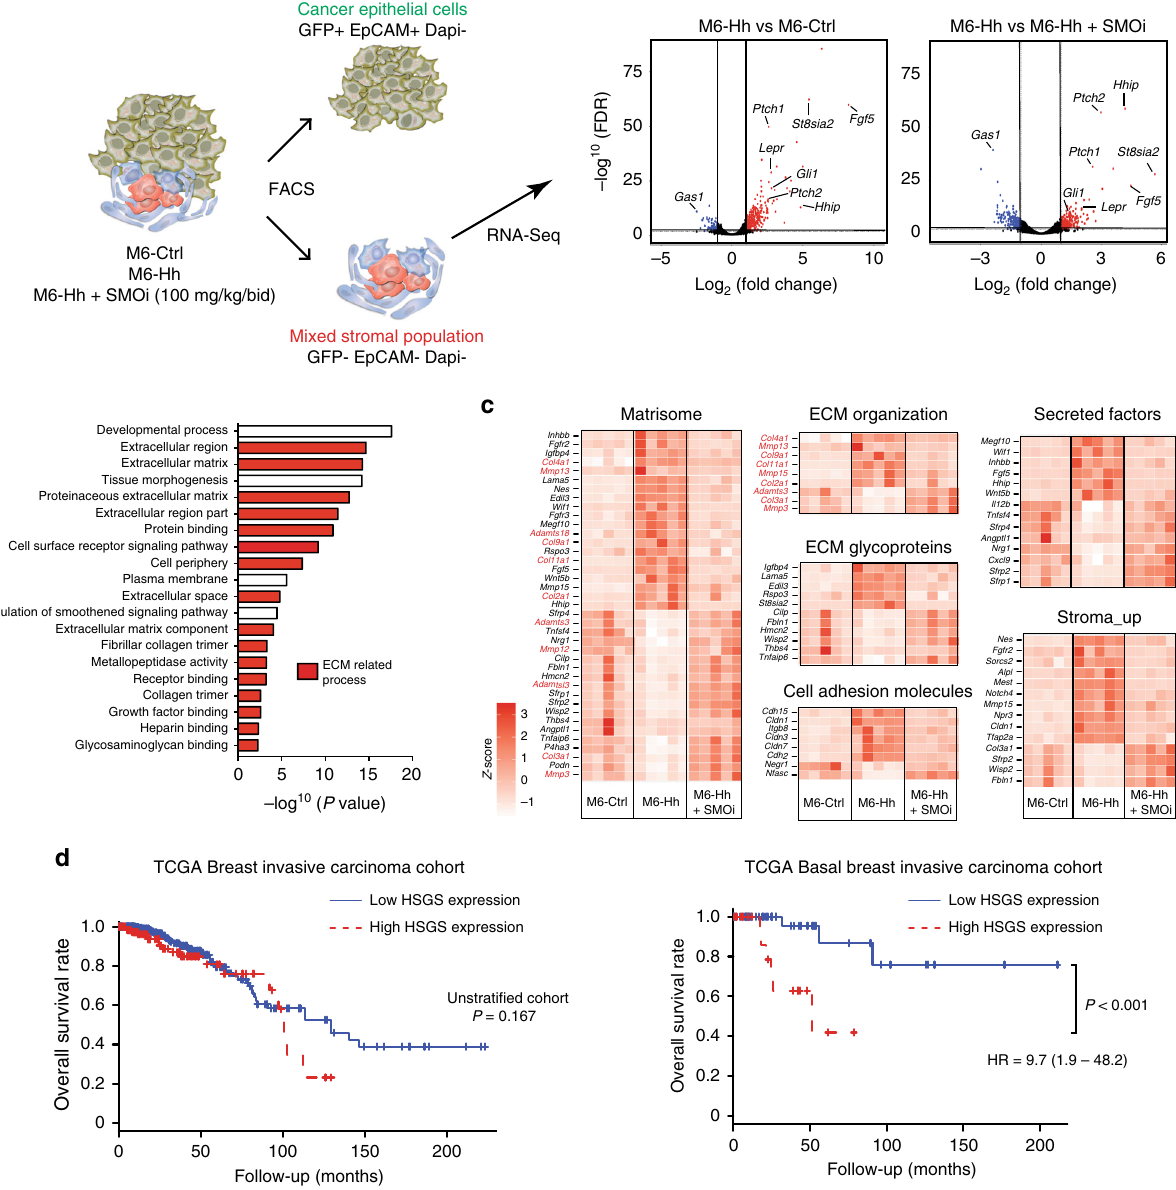
Fig. 2 Hh-activated stroma de fi nes a novel transcriptional signature robustly associated with poor-prognosis in TNBC. a Expression of genes signi fi cantly downregulated (blue) or upregulated (red) (cut-off log 2 (Fold Change) ≥ 2; vertical lines) in the stroma of M6-Hh tumors compared to the stroma of M6- Ctrl or M6-Hh tumors treated with SMOi (100 mg/kg/bid), plotted against FDR values (horizontal lines indicate − log 10 (FDR) > 2). Each symbol represents the transcriptome of the stromal population from fi ve biological replicates per treatment group. b RNA-Seq analysis reveals signi fi cant enrichment of GO groups related to ECM organization and production in M6-Hh tumor stroma (FDR q value < 0.05). c Heat maps demonstrating relative expression levels of gene-sets de fi ned by RNA-Seq analysis. Genes highlighted in red represent those that are directly involved in ECM production. Data show normalized row Z -score ( n = 5 biological replicates for each treatment group). d Kaplan − Meier curves of overall survival in unstrati fi ed breast cancer patients and in patients with basal, TNBC. Blue and red lines represent low and high Hh-stromal gene signature expression (HSGS), respectively. Statistical signi fi cance was determined using the Log-rank test; *** P <